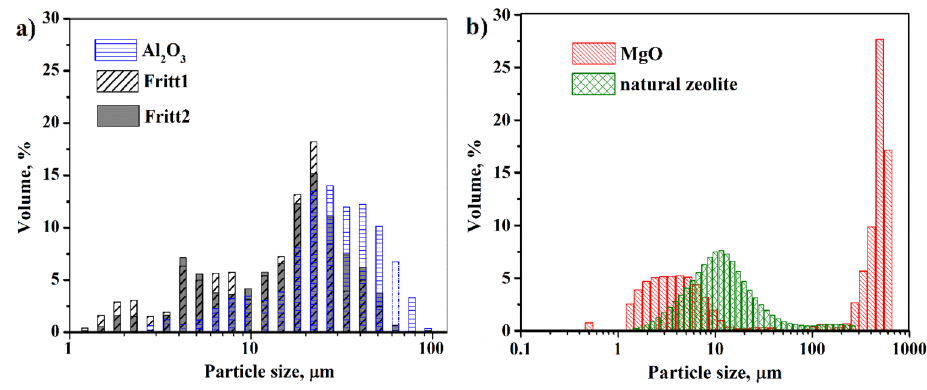
Figure 2. Particle size distribution of the different